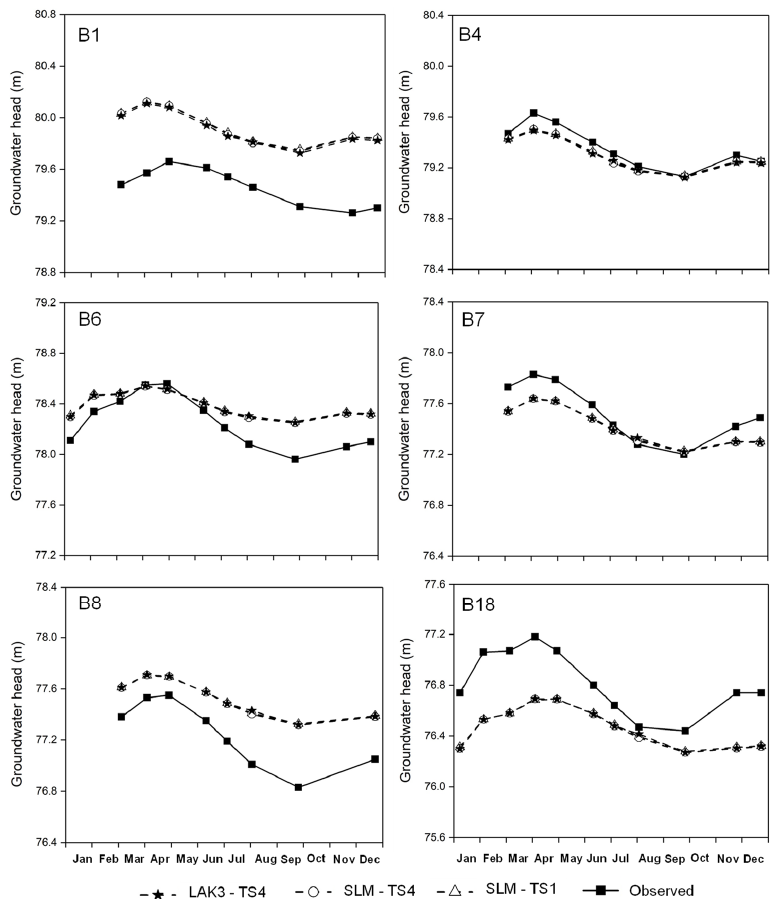
Figure 5. Comparison of the observed and simulated groundwater head at six different groundwater observation wells in 2008 (well locations are shown in Figure 3).